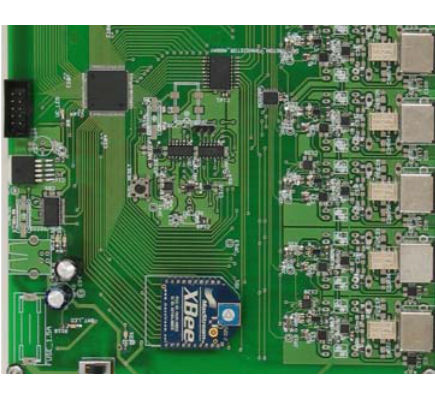
Figure 4. Image of the